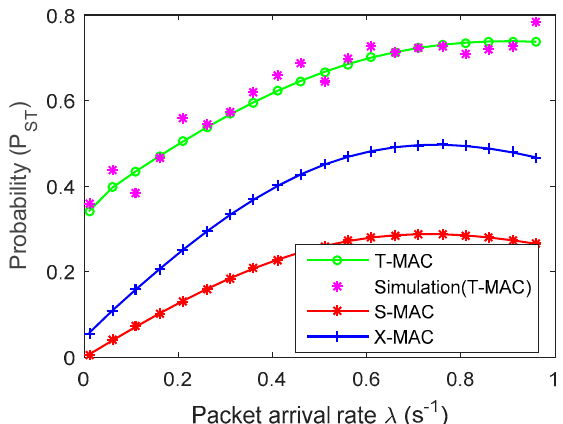
Figure 4. The successful transmission probability, P ST , in a cycle versus di ff erent packet arrival rates ⋋, for the T-MAC, S-MAC and X-MAC protocols.